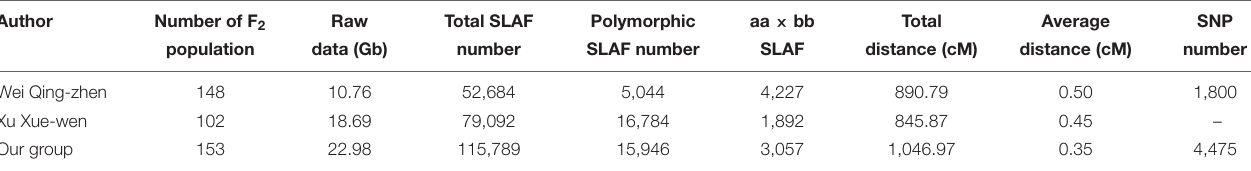
TABLE 5 | Comparison of three high-density genetic SNP